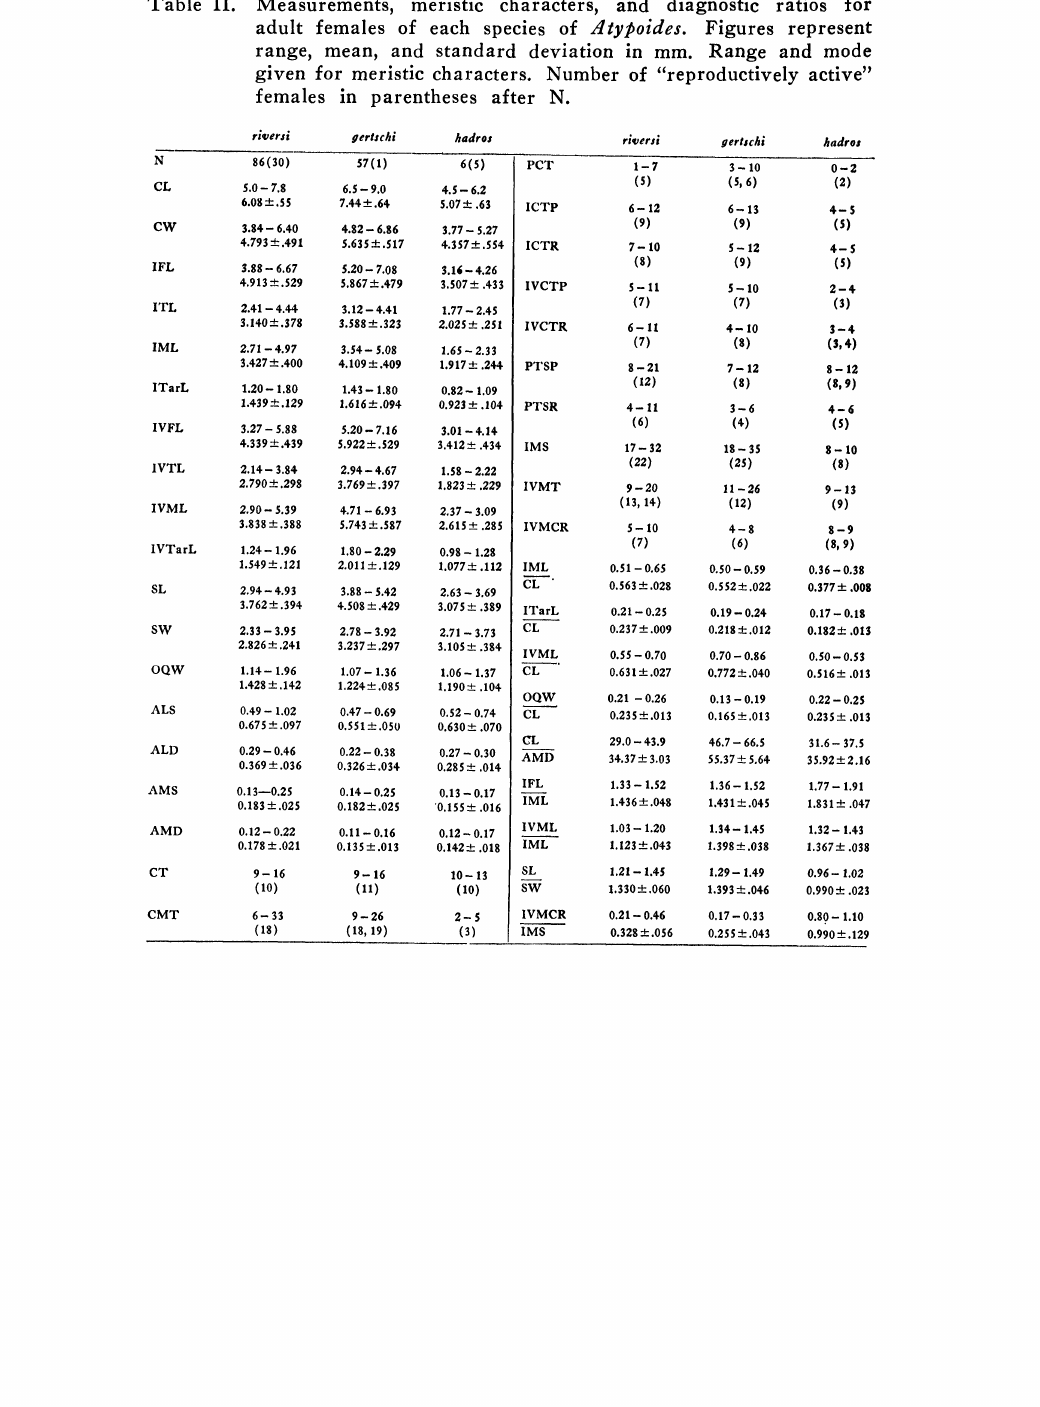
Table II. Measurements, meristic characters, and diagnostic ratios for adult females of each species of /ltyoides. Figures represent range, mean, and standard deviation in ram. Range and mode given for meristic characters. Number of "reproductively active" females in parentheses after